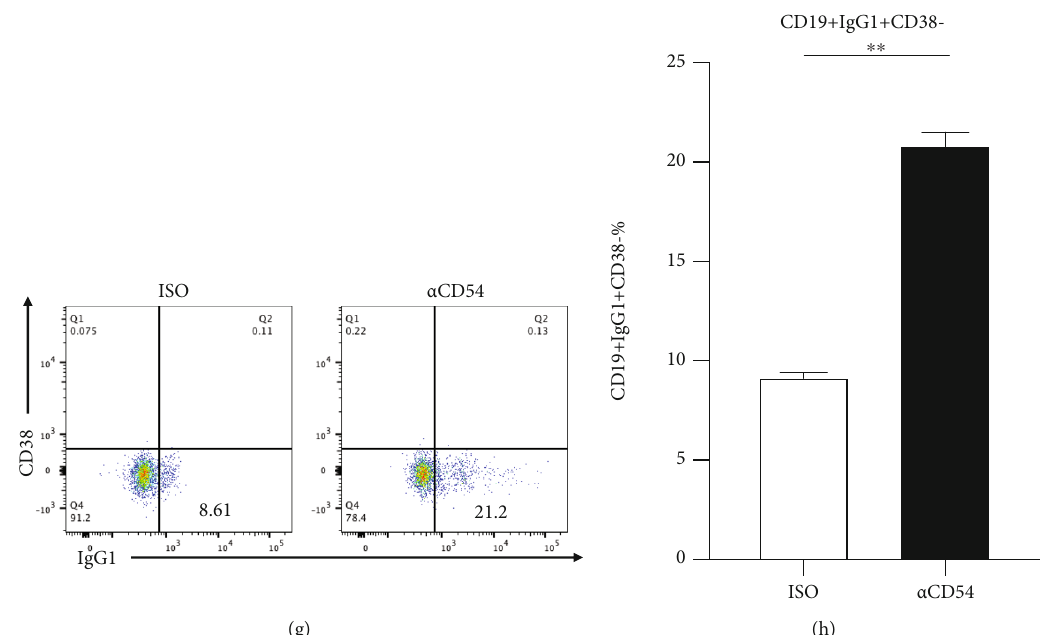
Figure 6: ICAM-1 attenuates IgG production in the coculture of in vitro activated CD4 + T cell and B cells. Wildtype CD4 + T cells and B cells were sorted from 6- to 8-week-old BALB/c mice by MACS, respectively. CD4 + T cells were stimulated by anti-CD3 and anti-CD28 antibodies for 72 hours. Then, 3 × 10 4 activated CD4 + T cells were cultured with 9 × 10 4 B cells. (a) Flow cytometric analysis of ICAM-1 expression on CD4 + T cells. (b) Increased expression levels of ICAM-1 on in vitro activated CD4 + T cells. (c – f) Total IgG (c), IgM (d), IgG1 (e), and IgG2a (f) levels in the supernatant with or without anti-ICAM-1 blocking antibodies were determined by ELISA. (g, h) Determination of di ff erentiated B cells after the coculture. Each group had at least fi ve mice for the analysis. ∗∗ p < 0 : 01 ; ∗∗∗∗ p < 0 : 0001